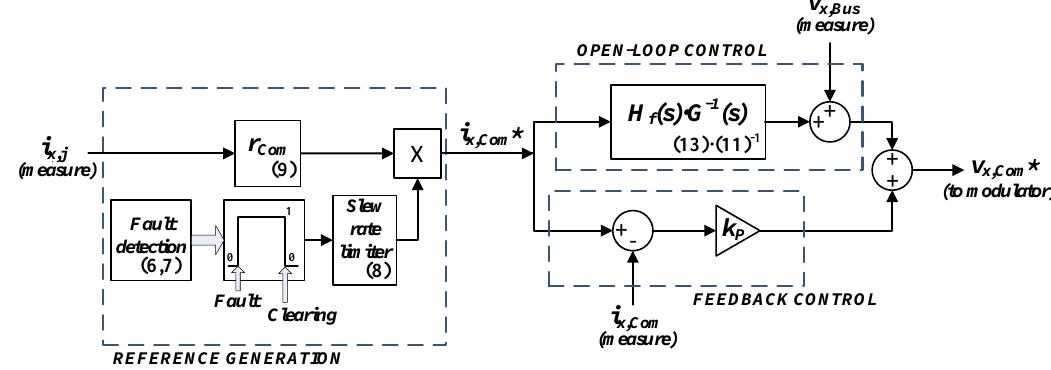
Figure 6. Block diagram of the proposed PFCA current control scheme.